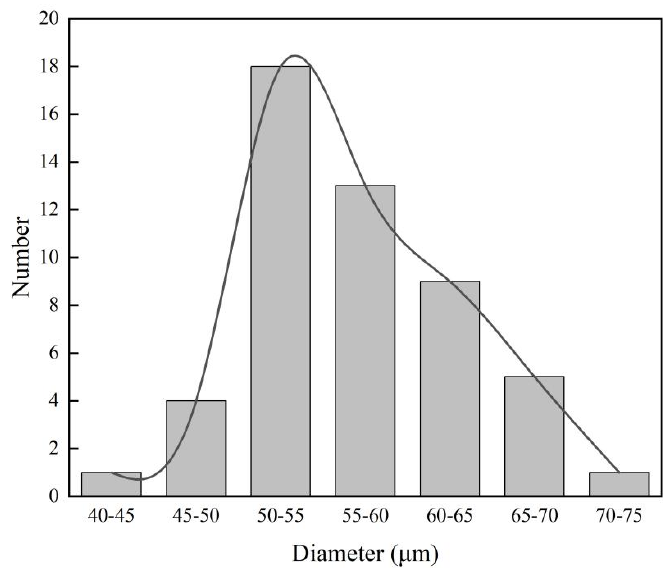
Figure 1. Particle diameter distribution of individual Mg microparticles.